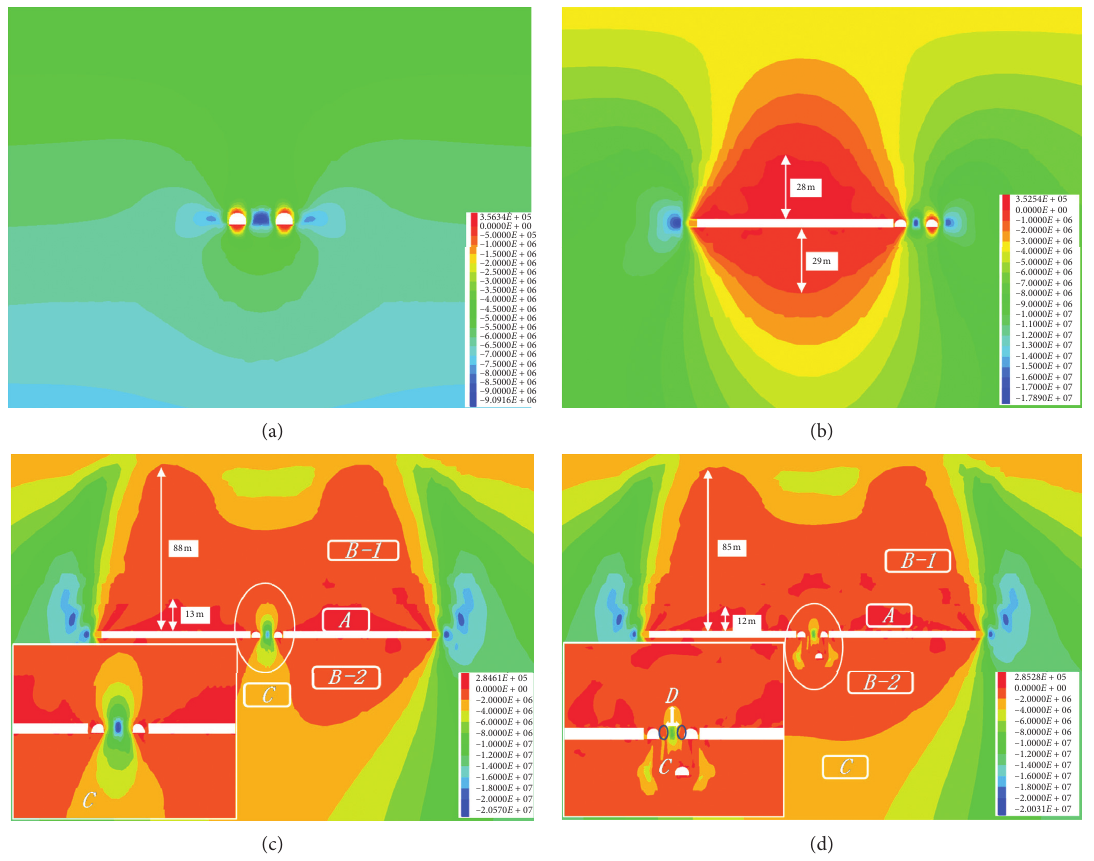
Figure 5: Vertical stress distribution of the surrounding rock in different stages of mining and excavation. (a) The mining roadway is excavated. (b) The 11173 mining face is mined out. (c) The 11173 mining face is mined out. (d) The 1118 1 3 haulage roadway is excavated.